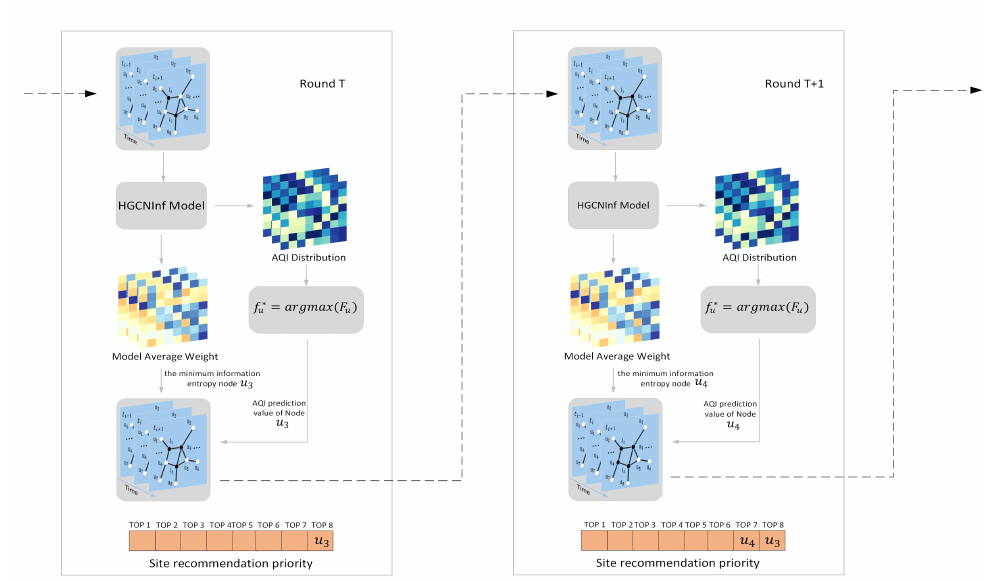
Figure 7. The basic framework of the monitoring-station location recommendation